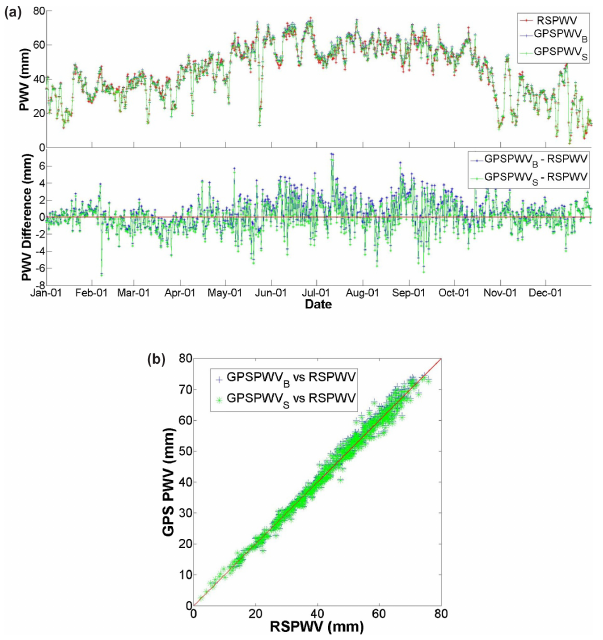
Figure 3. Comparison between PWV derived from radiosonde and GPS. RSPWV represents the PWV derived from radiosonde data. GPSPWV B and GPSPWV S respectively represent the GPS-derived PWV using Bevis T m equation and local specific T m equation. Table 3. Statistics of the differences between GPS PWVs and RS PWVs for 1 year of data in 2010. The difference (BIAS), the relative mean difference (RelativeBIAS), the relative mean absolute differ- ence (RMAD) and the root mean square error (RMSE) are shown. Compared BIAS Relative RMAD RMSE PWVs (mm) BIAS % % (mm) GPSPWV B /RSPWV 0.41 0.85 GPSPWV S /RSPWV 0.04